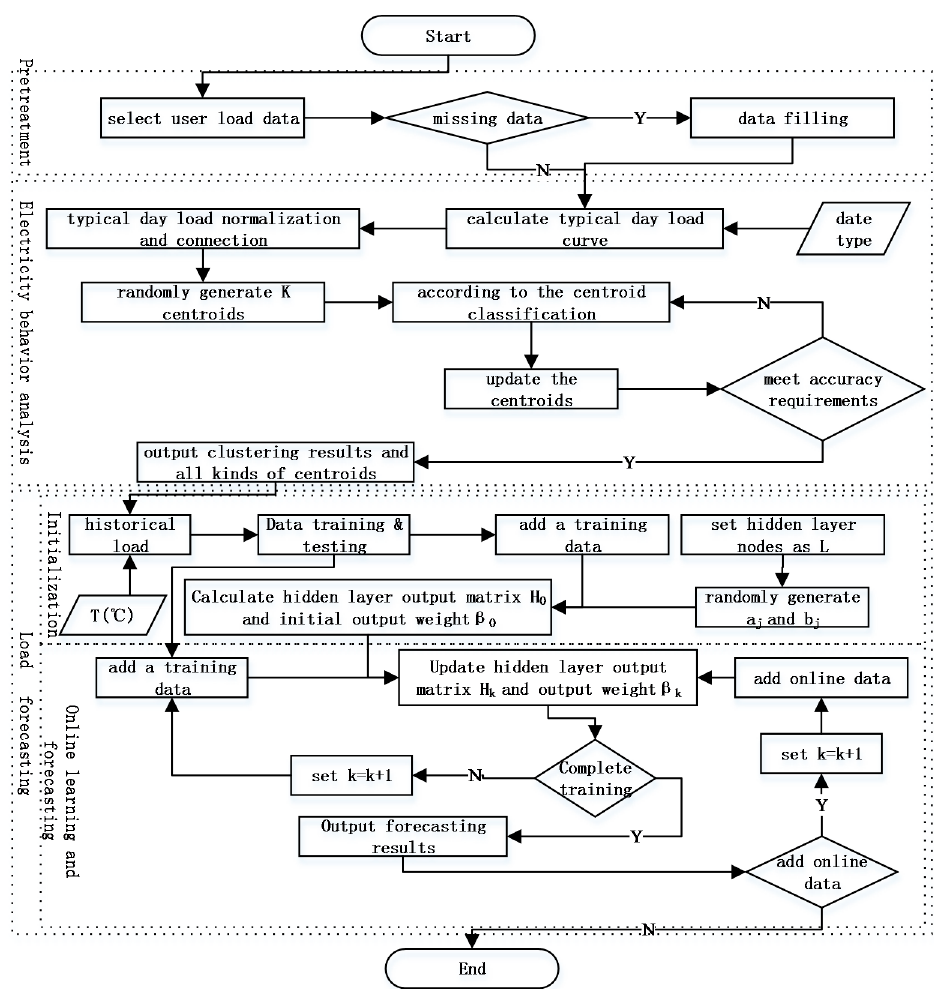
Figure 5. The flowchart of the forecasting model based on OS-ELM (Online Sequential Extreme Learning Machine).